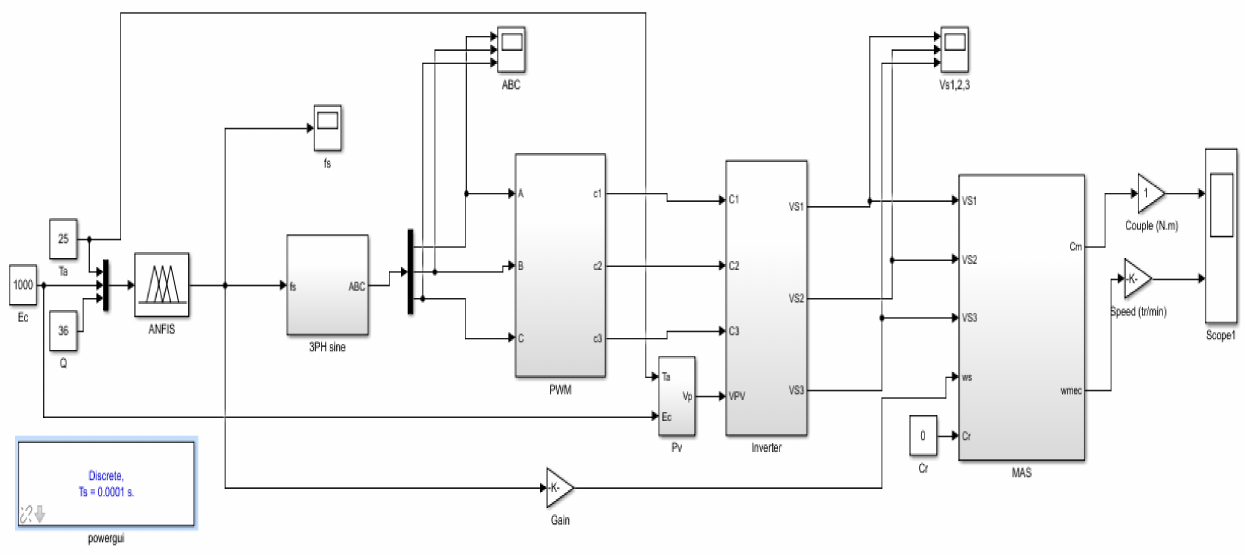
Figure 23. Simulink model of the intelligent ANFIS controller design for the photovoltaic pumping